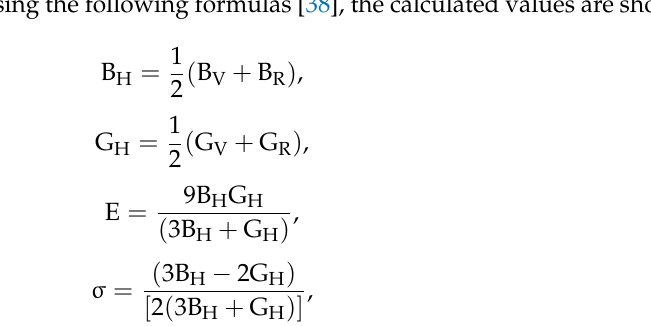
where the subscript symbols H denotes the modulus values obtained by the Hill approx- imation. The subscript V and R mean the modulus values obtained by the Voigt and Reuss approximation methods, respectively. Furthermore, the Voigt approximation limits the maximum of elastic modulus and the Reuss approximation is considered to be the mini- mum of elastic modulus. The Hill approximation uses the average value of Voigt and Reuss to express the elastic constants of materials. Table 3. The calculated bulk modulus (GPa), shear modulus (GPa), Young’s modulus (GPa), B/G, Poisson’s ratio and Vickers hardness (GPa) of Al 3 TM compounds.